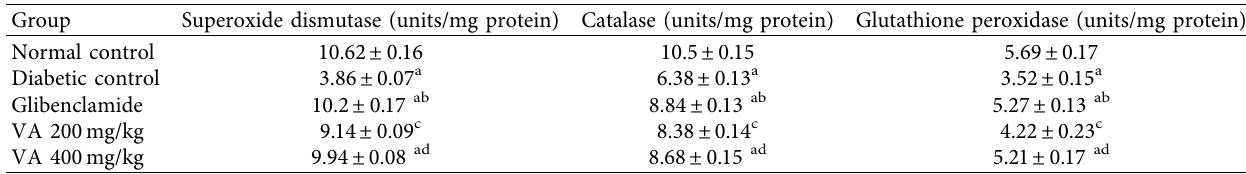
Table 5: Protective effect of V . album extract against alloxan-induced